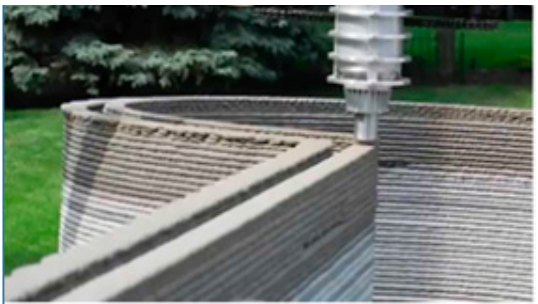
Figure 1. Extrusion-based additive manufacturing of concrete: deposition process. Reproduced from Reference [6].